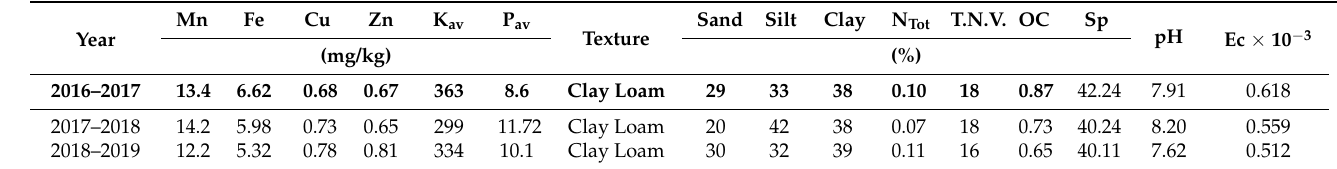
Table 1. Results of physical and chemical analysis of soil (0–30 cm) of the Qamloo Dryland